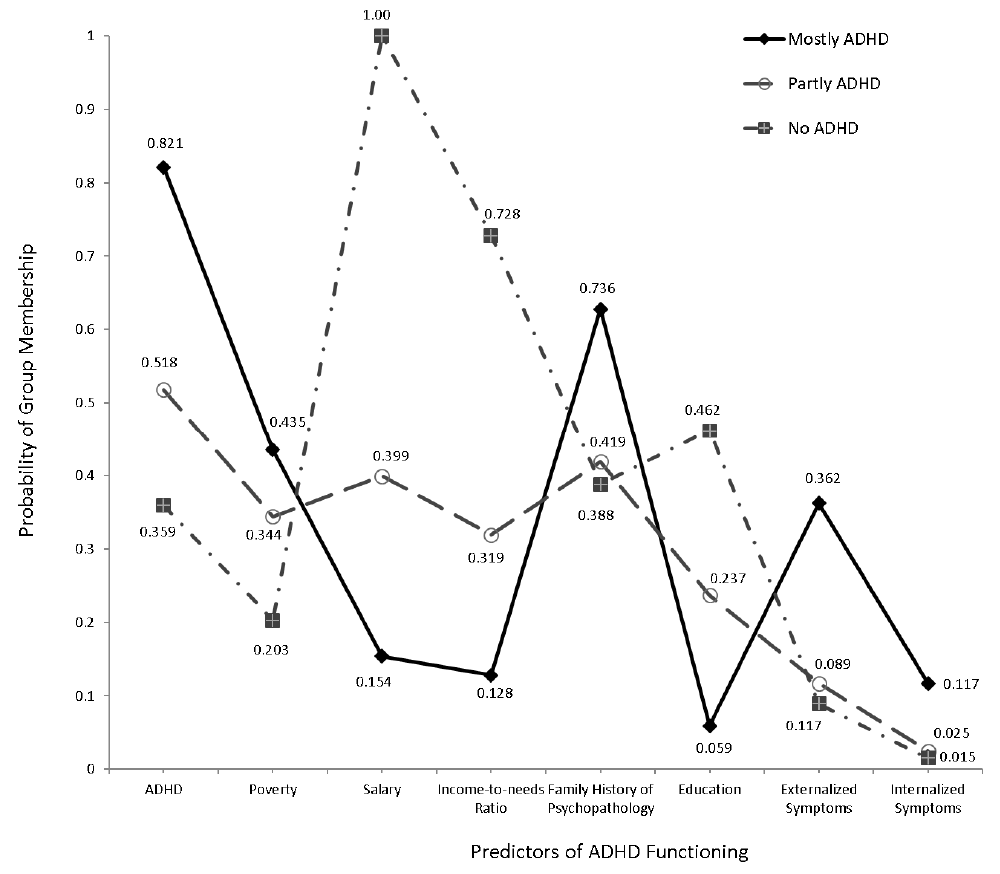
Figure 2. Three-Class latent class model using Study 2 data. Table 3. Three-Class Model and Significance of Indicators on Classifying Three Independent Classes of